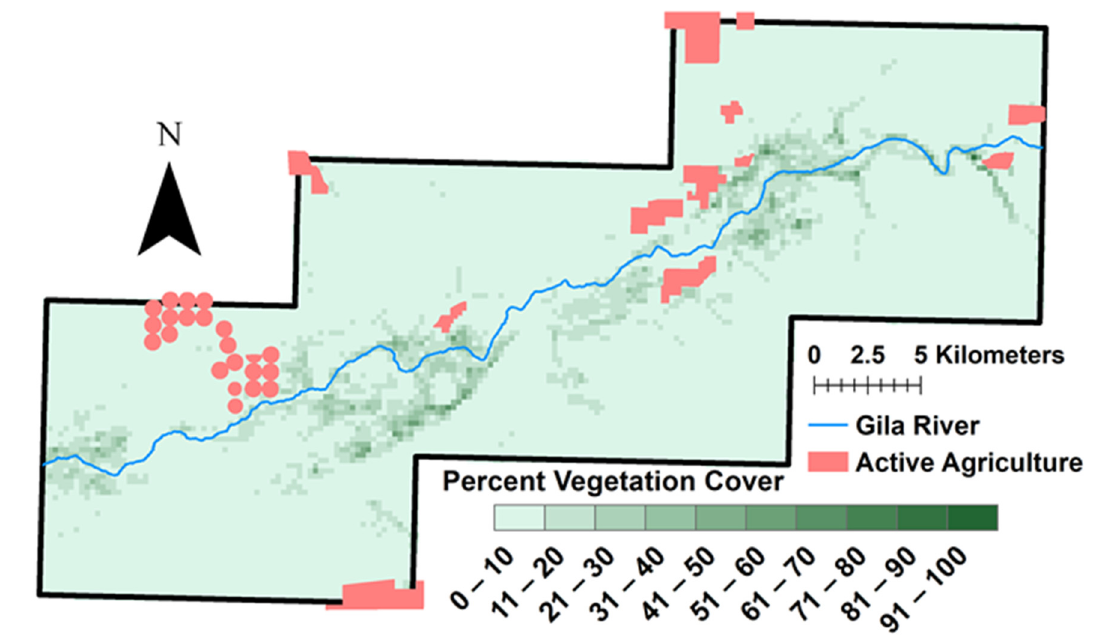
Figure A3. Percent Vegetation Cover 2019. 250 m tessellation of vegetation cover in 2019. Areas with less cover are shown in light green and areas with greater cover are shown in dark green. Areas of active agriculture are shown in pink.